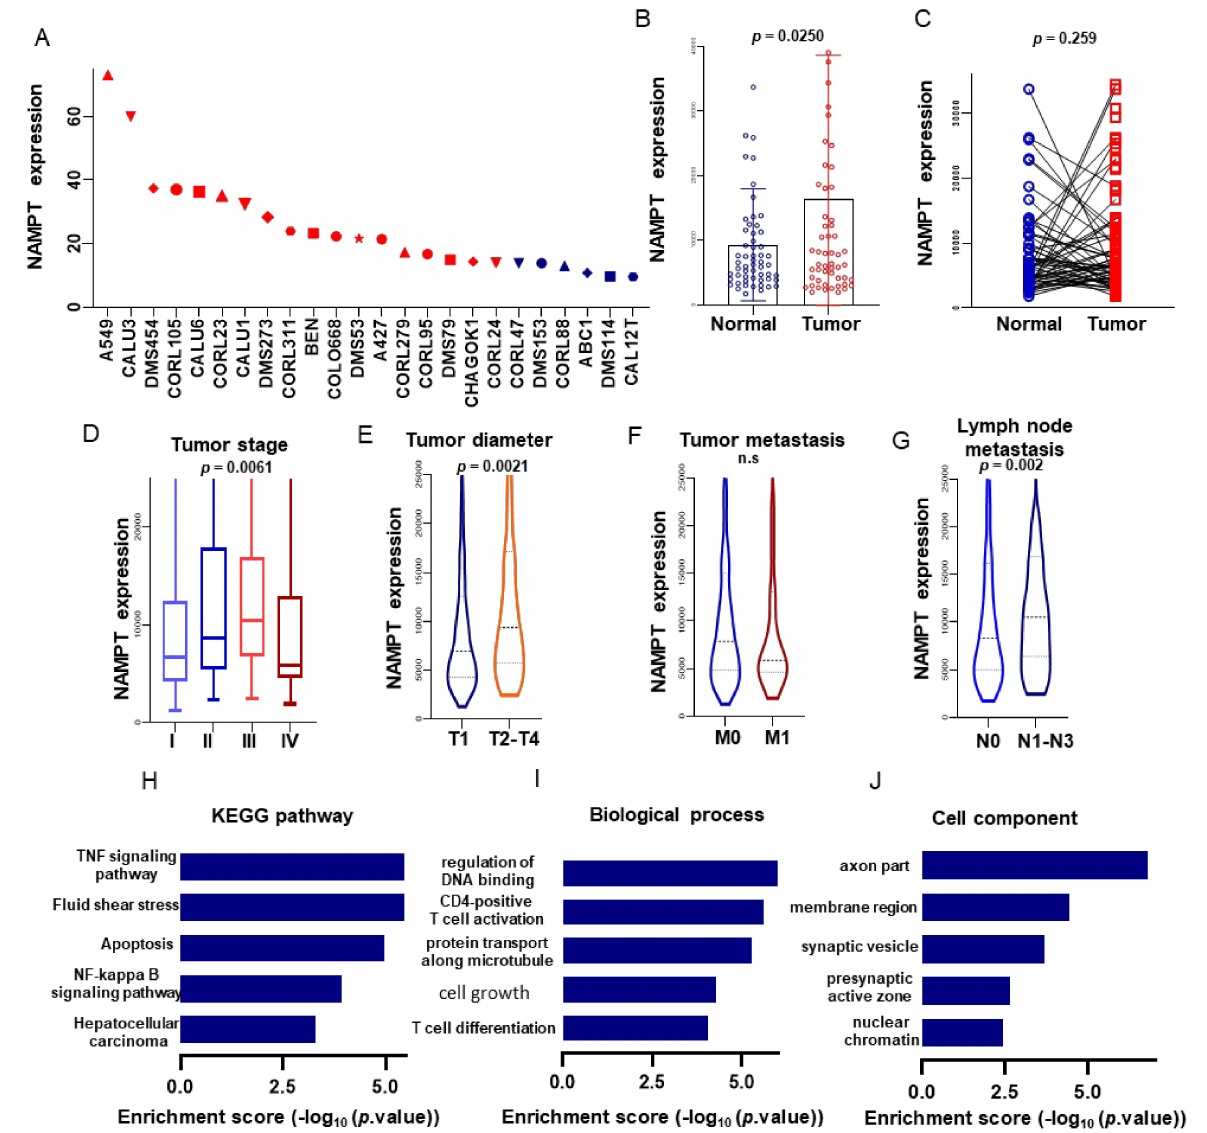
Figure 5. The expression levels of NAMPT in different lung cancer cell lines were downloaded from CCLE ( A ). The expression level of NAMPT in tumor tissues and adjacent tissues of LUAD patients was significantly different ( B ). Paired difference analysis ( C ). The relationship between NAMPT and LUAD stage, tumor diameter, tumor metastasis, and lymph node metastasis ( D – G ). KEGG analysis and GO analysis of differentially expressed genes related to NAMPT ( H – J